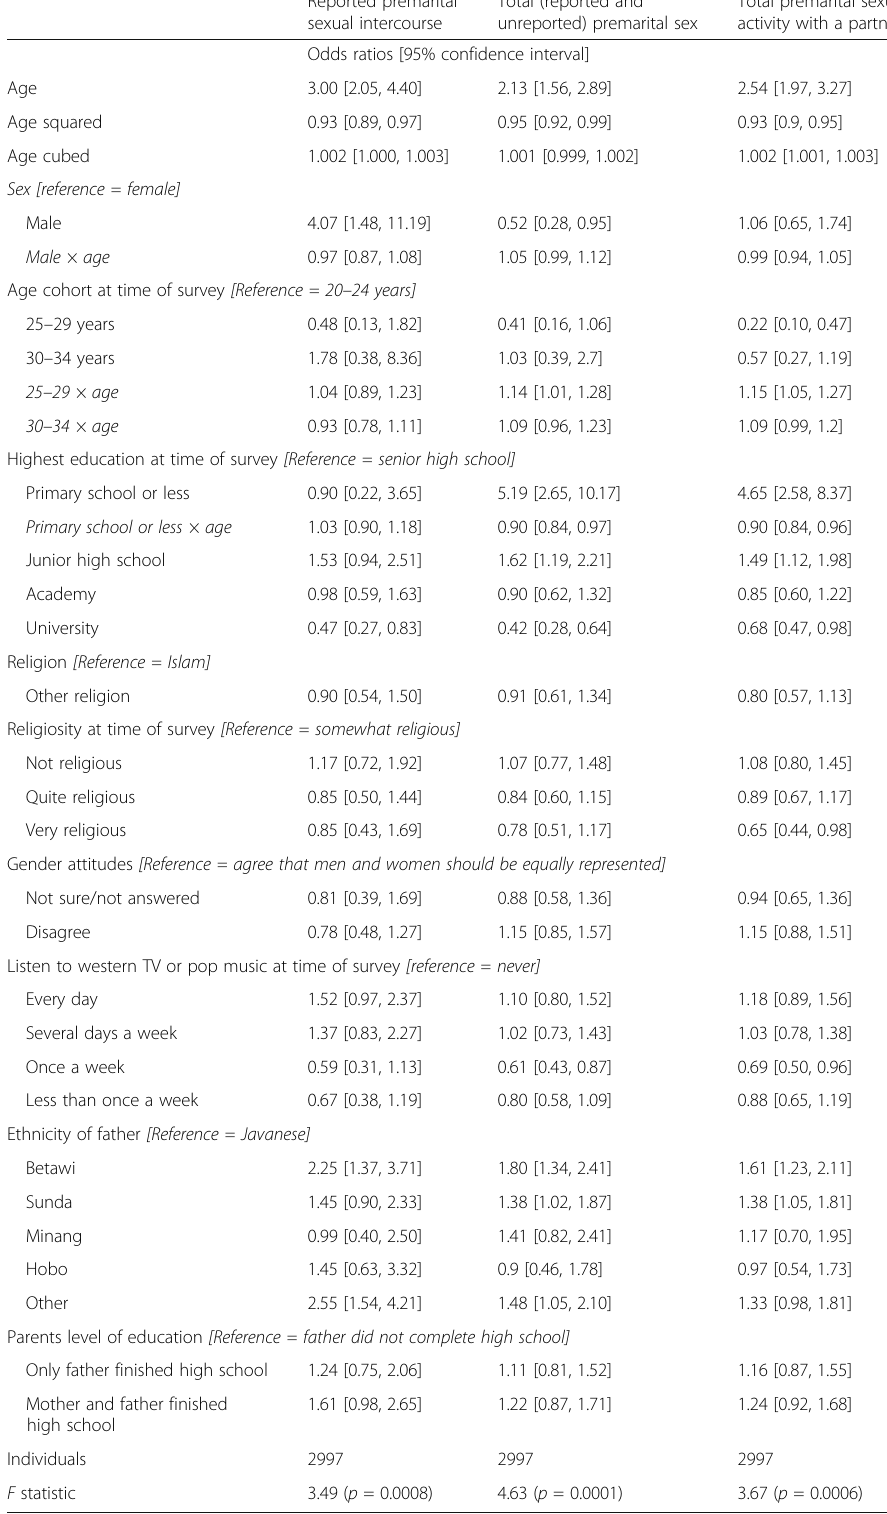
Table 4 Factors associated with the reporting of premarital